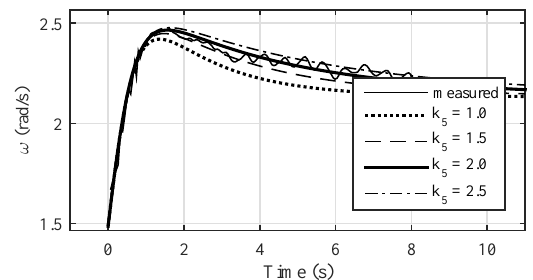
Figure 3. Examples of numerical results for different values of k 5